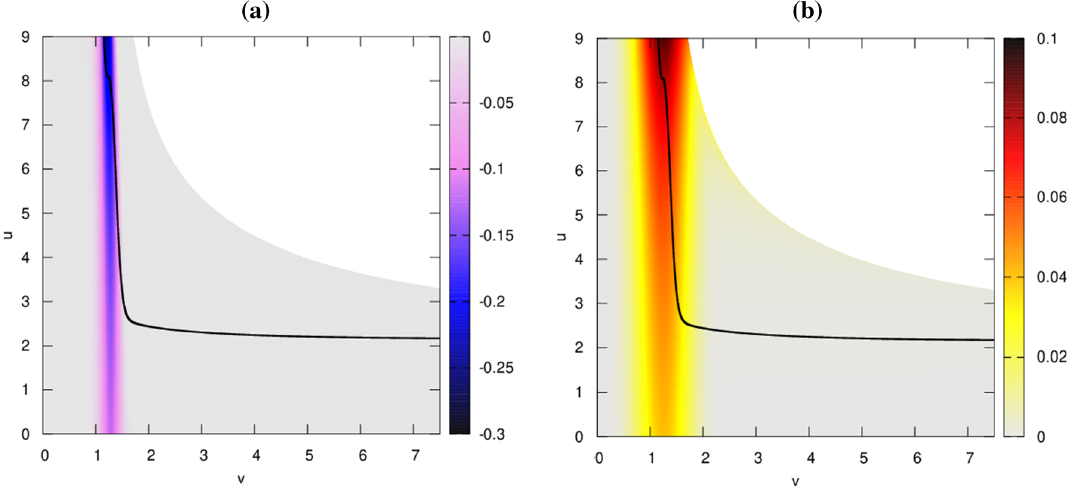
Fig. 14 The (v u ) -distribution of a the neutral scalar field, h , and b the moduli of the complex scalar field, | s | , for the same parameters and field amplitudes as in Fig.